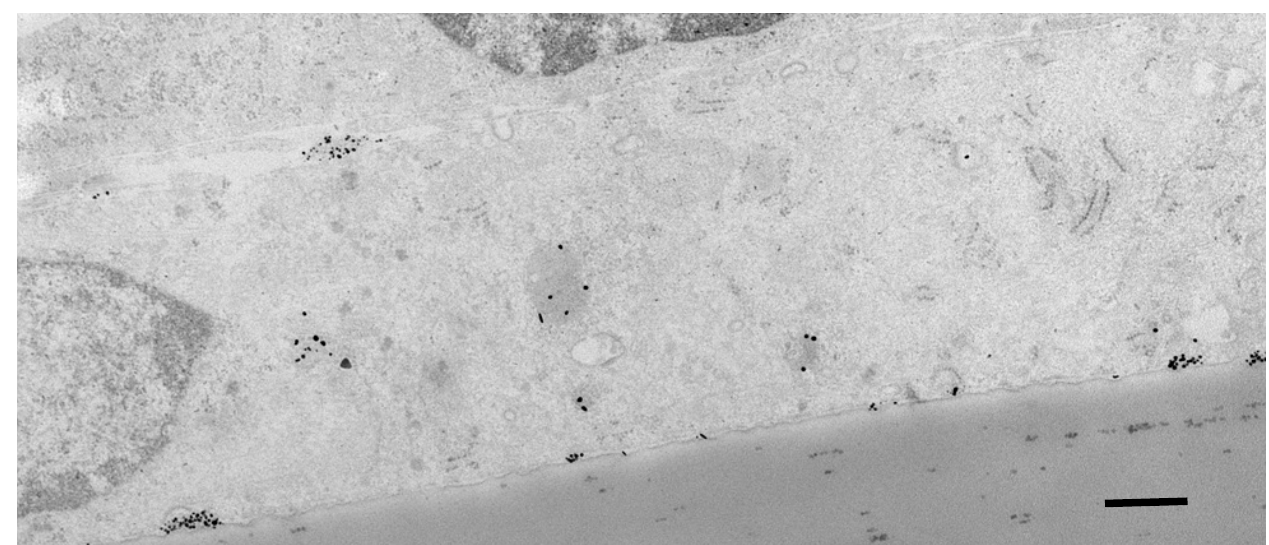
Figure 4. TEM silver-enhanced image showing transport of 7-nm gold glyconanoparticles carrying 40 bp dsDNA oligonucleotides across the human brain endothelial cell line hCMEC/D3 in vitro. Nanocarriers (electron-dense black dots) are transported from the apical surface of the cell (upper) to the basal surface (lower) both in vesicles and by cytosolic transfer. Nanocarriers can be seen in clusters released from vesicles at the basal membrane. Image is courtesy of Dr. Nayab Fatima. Scale bar = 100 nm.